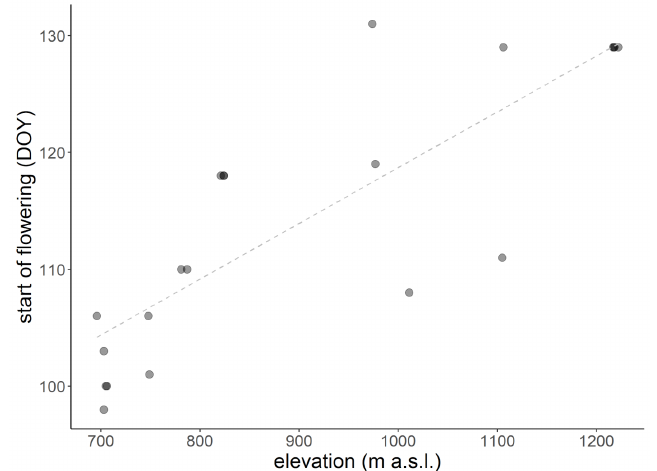
Figure 6. Scatterplot showing the relationship between the start of birch flowering (DOY) in 2020 and elevation in the region of Garmisch-Partenkirchen.